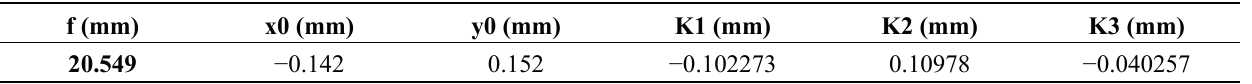
Table 1. Interior orientation of the